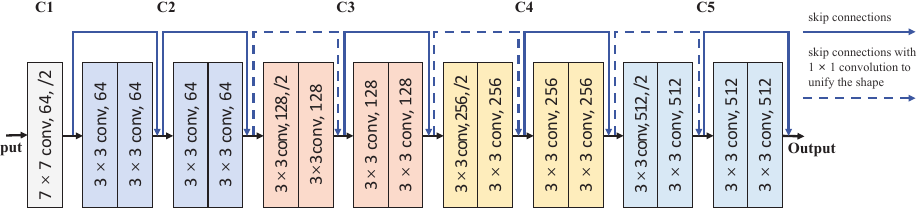
Figure 3. The structure of the feature extraction module. k × kconv , n means the kernel size of the convolution layer is k and the kernel number of the convolution layer is n, while / p means the stride of the convolution layer is p. Different colors represent different